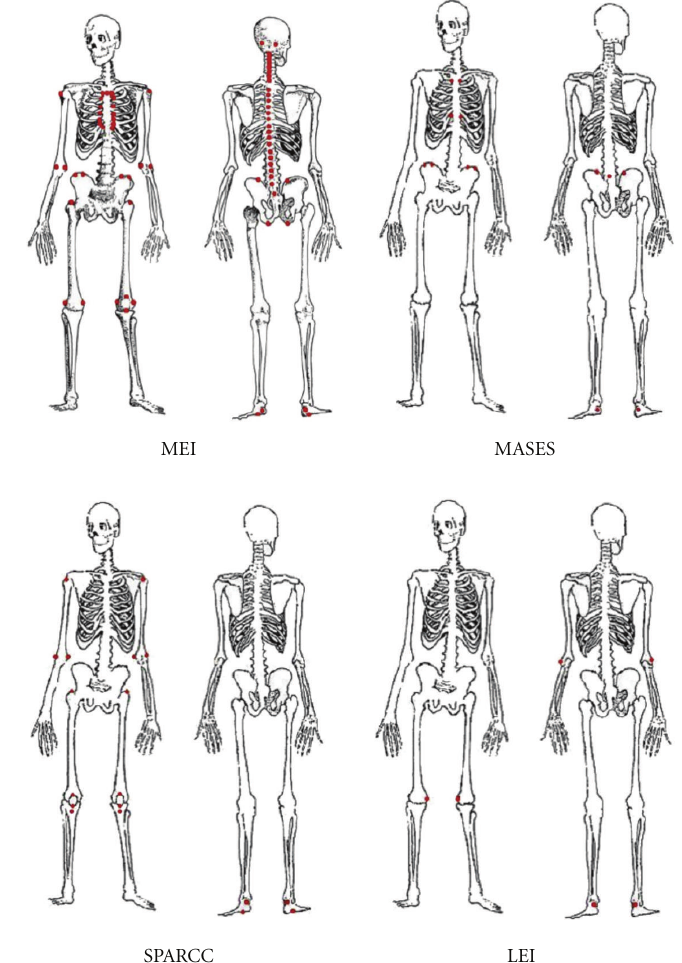
Figure 1: Enthesitis sites recorded by the principle enthesitis indices [32]. MEI:Mander Enthesitis Index; MASES:Maastricht Ankylosing Spondylitis Enthesitis Score; SPARCC:Spondyloarthritis Research Consortium of Canada Enthesitis Index; LEI:Leeds Enthesitis Index.